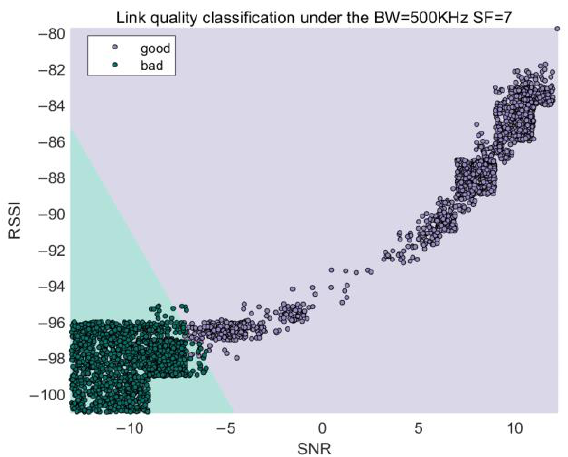
Figure 6. Link quality classification under BW = 500 Khz, SF = 7.